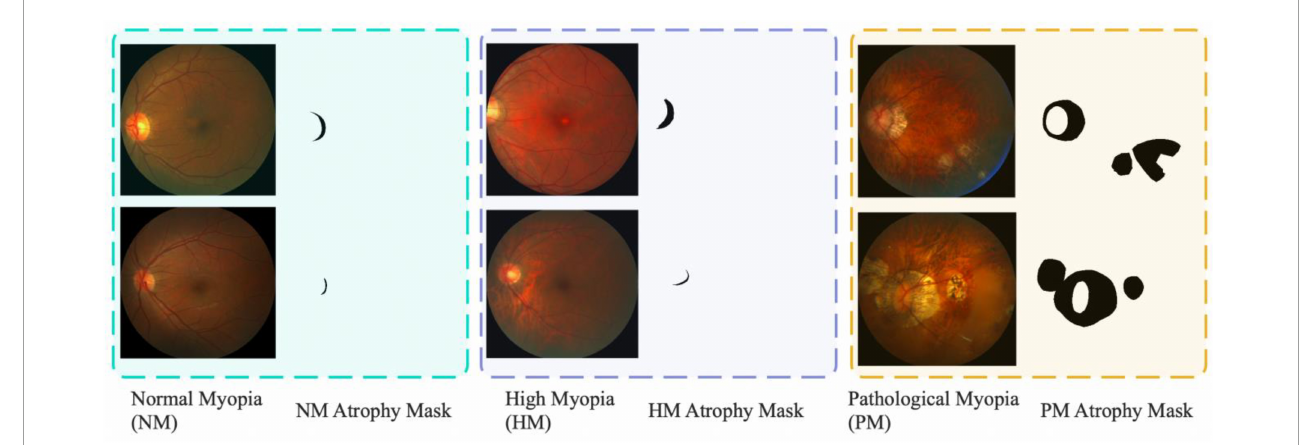
FIGURE1 Fundus images selected from iChallenge-PM dataset. The dataset contains three types of 2D fundus images (NM, HM, PM).